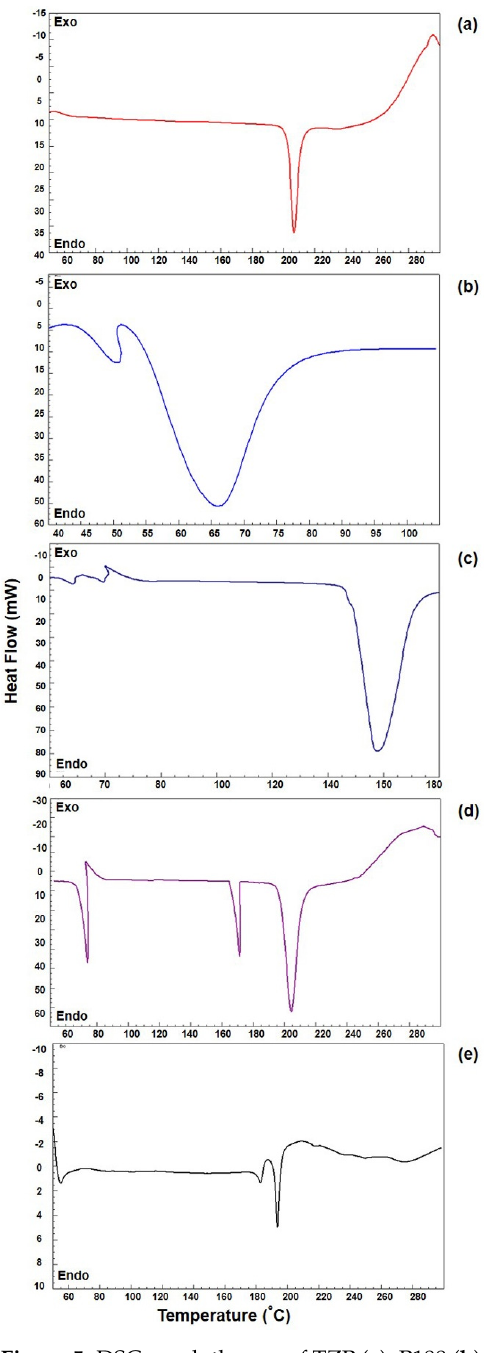
Figure 5. DSC − endotherms of TZP ( a ), P188 ( b ), mannitol ( c ), physical mixture (PM) of TZP, P188, and mannitol ( d ) and lyophilized NC 1 ( e ).